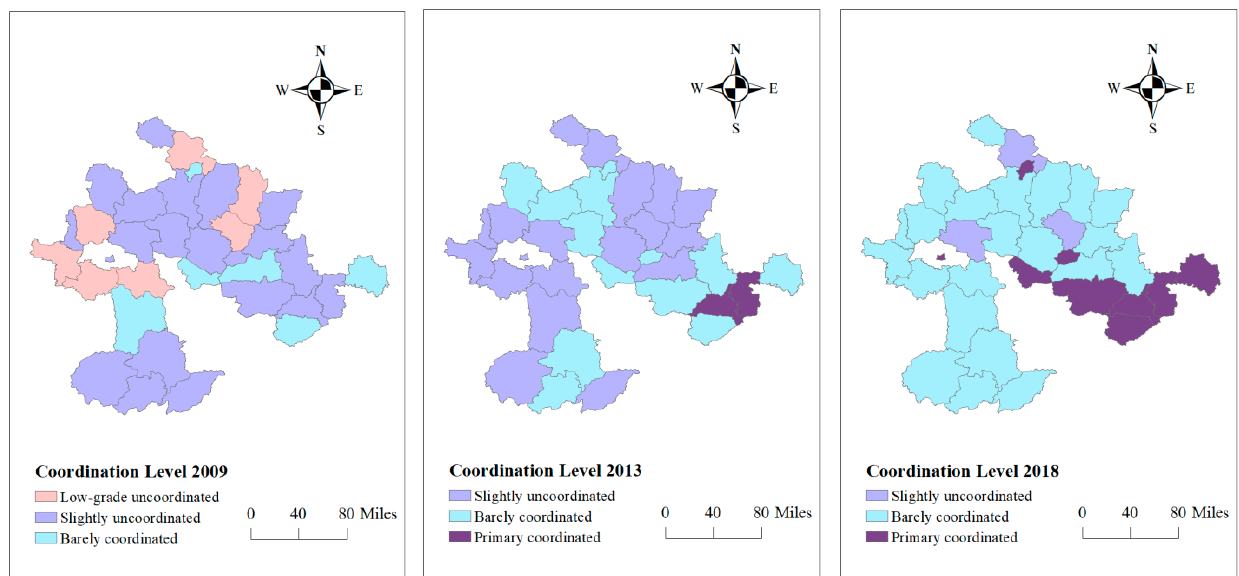
Figure 3. Spatial pattern evolution of coupled coordination degree of APLE system.